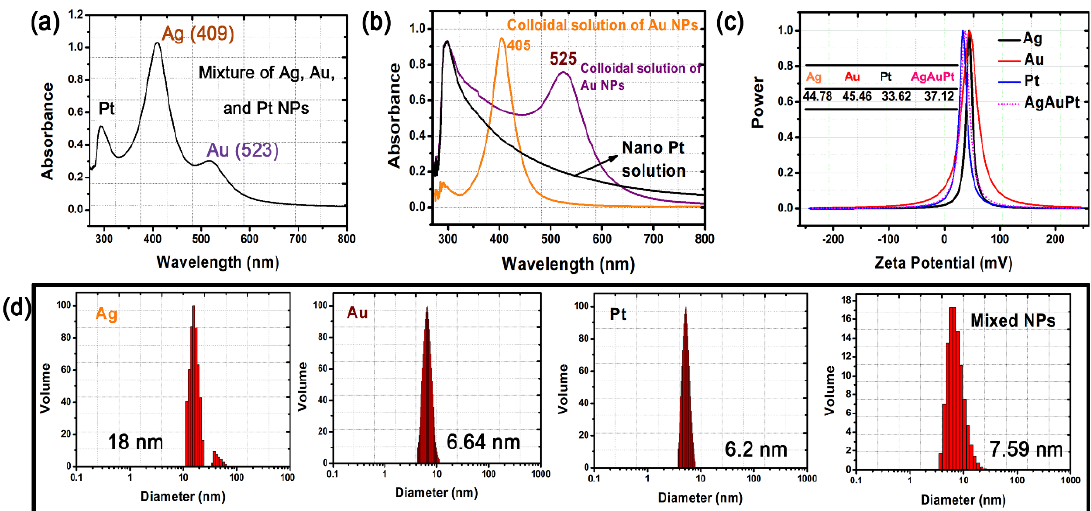
Figure 1. ( a , b ) UV–vis spectra, ( c ) zeta potentials, and ( d ) size distributions of the single and mixed solutions of Ag, Au, and Pt nanoparticles (NPs).